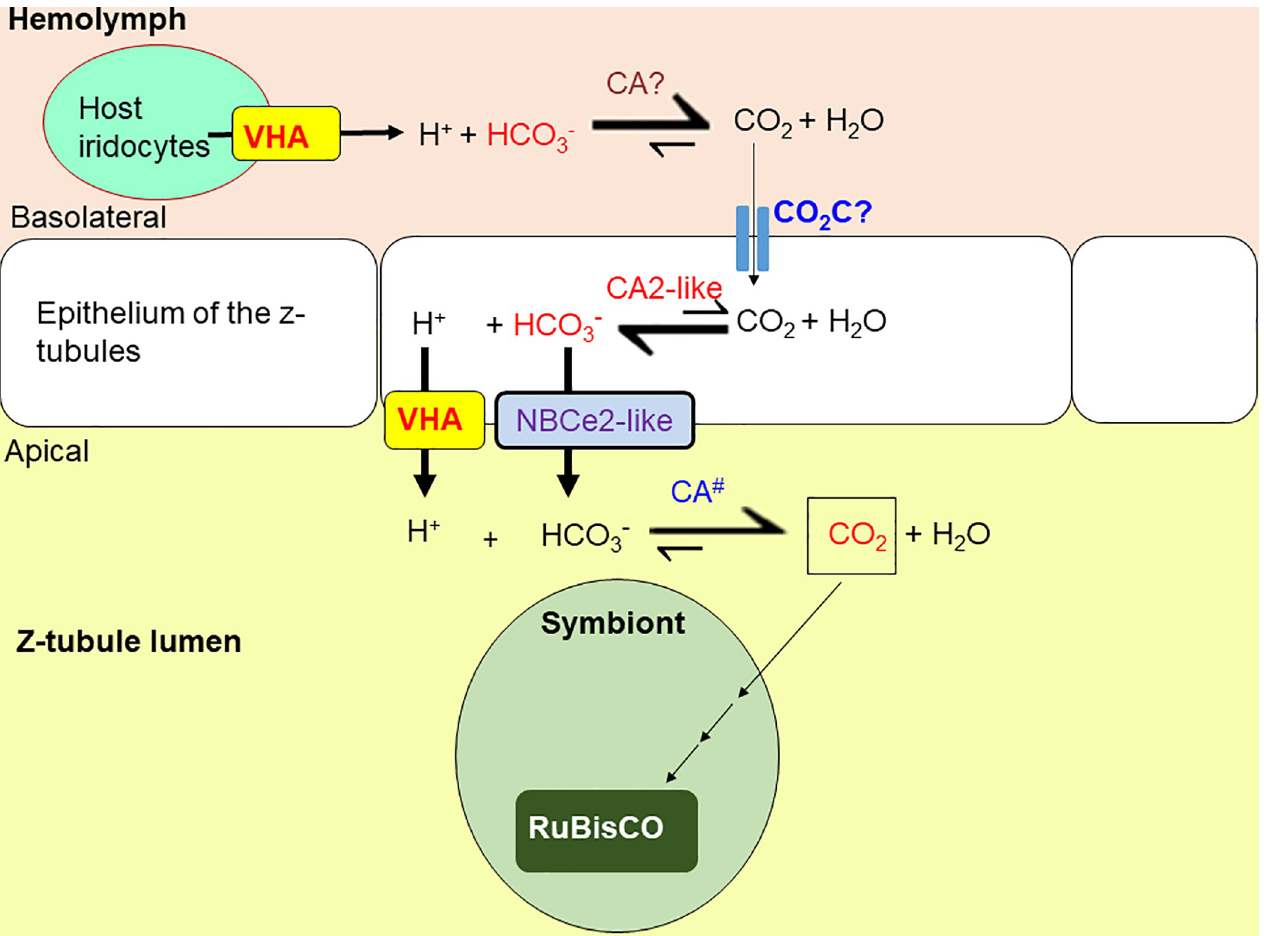
Fig 7. A proposed scheme for the role of a homolog of electrogenic Na + -HCO 3 − cotransporter 2-like (NBCe2-like) in the host-mediated carbon- concentrating mechanism (CCM) to transport HCO 3 − across the apical membrane of the epithelial cells of the zooxanthellal tubules (z-tubules) into the luminal fluid in the the outer mantle of Tridacna squamosa . The H + secreted by the host irridocytes through vacuolar H + -ATPase (VHA) [24] could augment the dehydration of HCO 3 − in the hemolymph to CO 2 catalyzed by a hypothetical extracellular CA that is secreted by the host (CA?). CO 2 could then permeate through an unknown CO 2 channel (CO 2 C?) into the epithelial cells of zooxanthellal tubules, and be hydrated back into HCO 3- catalyzed by the cytosolic carbonic anhydrase 2-like (CA2-like) [25] in the cytoplasm. Subsequently, cytoplasmic HCO 3 − could be transported through the apical NBCe2-like protein (this study) into the luminal fluid where the symbionts are residing. The epithelial cells that form the zooxanthellal tubules could secrete H + through VHA localized at the apical membrane [24]. The secreted H + could augment the dehydration of HCO 3 − to CO 2 in the luminal fluid catalyzed by a hypothetical extracellular carbonic anhydrase (CA # ) of symbiont origin. Eventually, CO 2 is absrobed by the symbionts and utilized by form II ribulose-1,5-bisphosphate carboxylase/oxygenase (RuBisCO) during photosynthesis